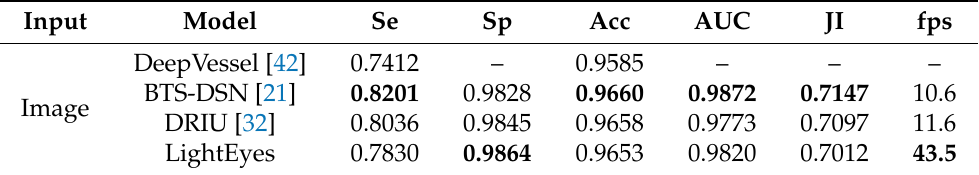
Table 7. Segmentation results of vessel on the STARE dataset (best results shown in bold).